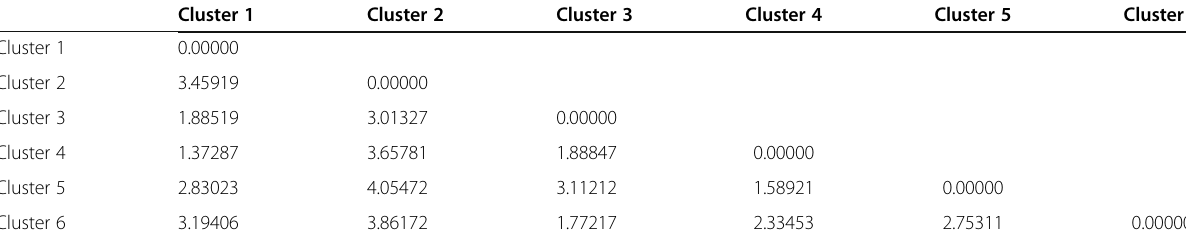
Table 8 Distances between clusters centroids – Existing network